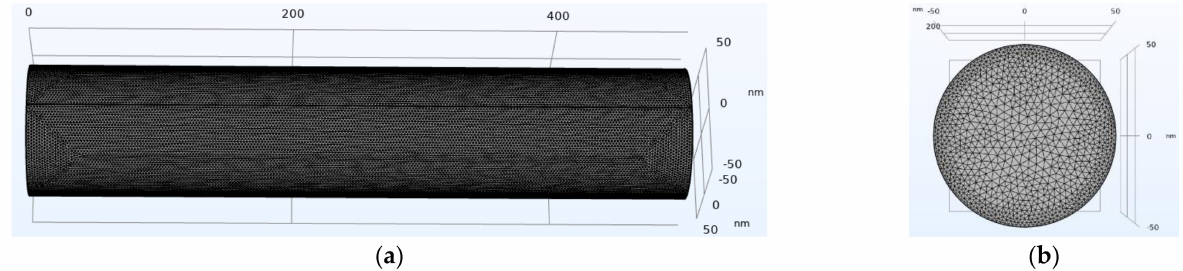
Figure 1. Capillary model. ( a ) front view; ( b ) side view.